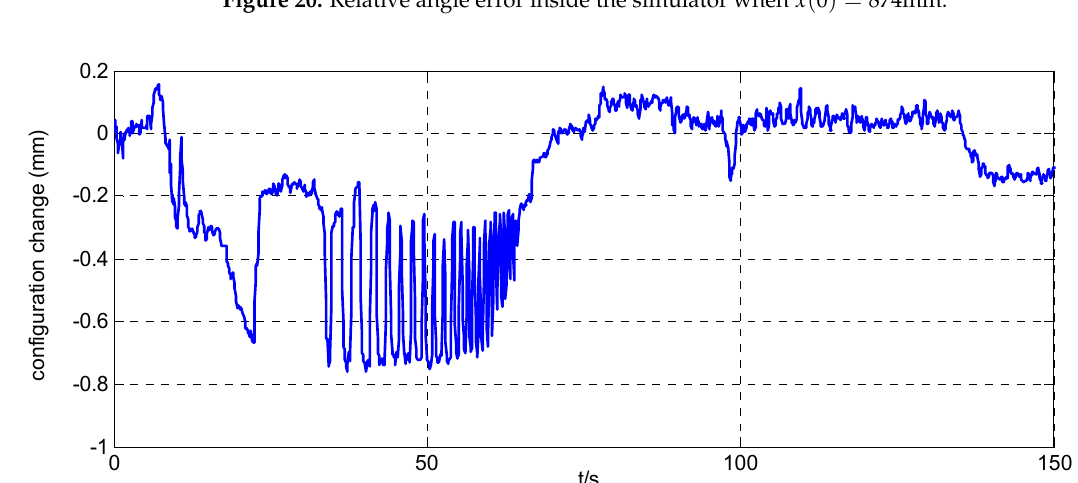
( ) 0 874 x mm = . Figure 21. Relative position error inside the simulator when x ( 0 ) =